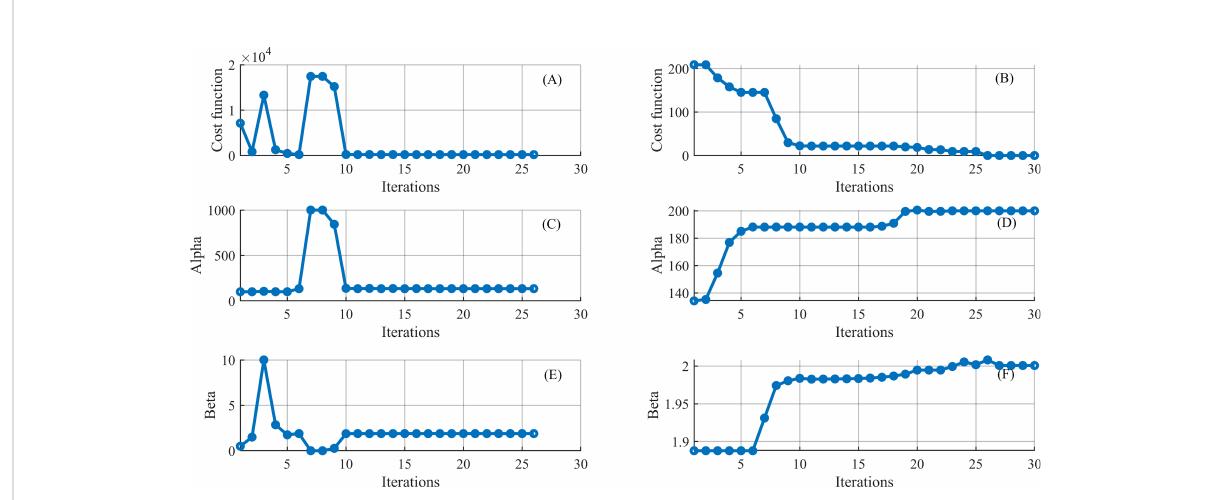
FIGURE 9 The evolution of the cost function, a , and b with LMBM (A, C, E) and LBFGS (B, D, F) for B _ ab experiment, respectively.